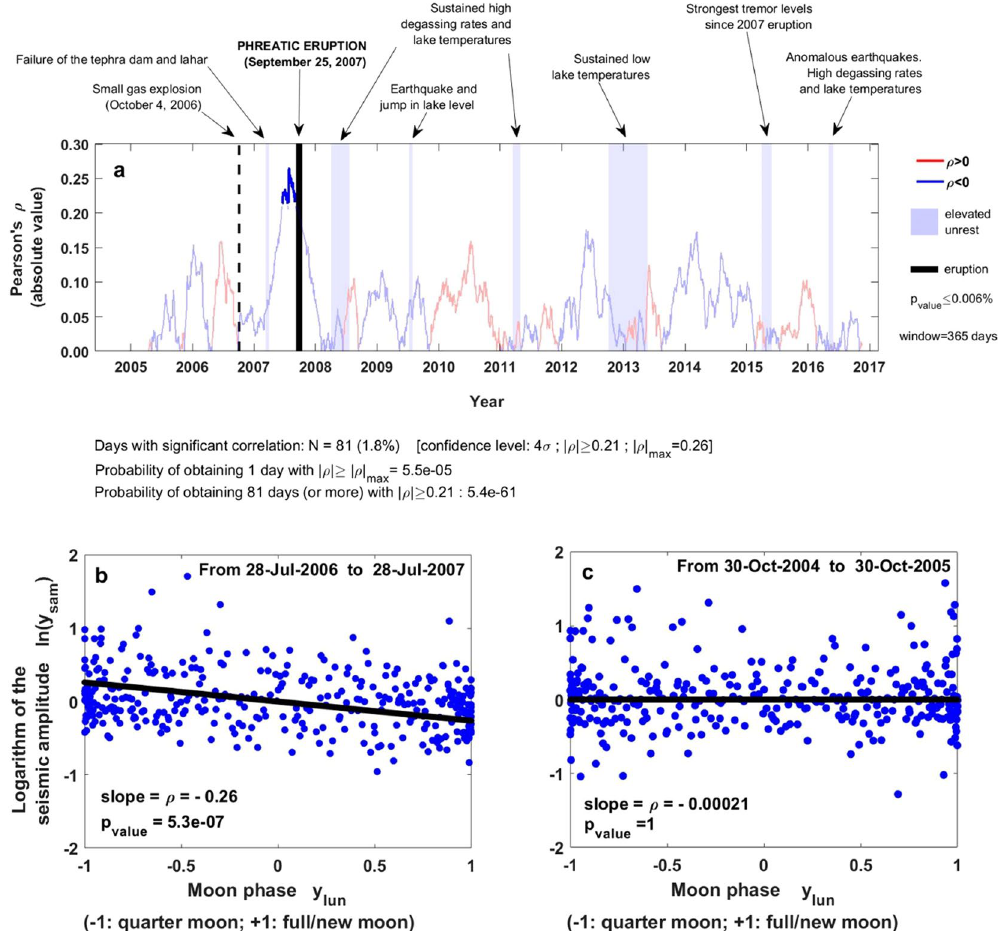
Figure 2. Luni-seismic correlation at Ruapehu. ( a ) Pearson coefficient ( ρ ) for 1-year backward windows. Positive and negative correlations are in red and blue, respectively, shaded regions represent unrest episodes 32 , and deep blue means p value < 0.006%. This plot depicts the case N = 81 days of significant correlation, but we find N = 59–86 days (after repeating the method 500 times) depending on the random values used to replace gaps and spikes (Methods, Section 1). The probability of obtaining by chance N days with significant correlation is therefore in the range ~10 − 36 –10 − 64 (Supplementary Fig. S5). ( b ) Logarithm of the daily median seismic amplitude ln ( y sam ) versus moon phase y lun ( t ) for the 365 days preceding July 28, 2007; this is the period with maximum correlation obtained. ( c ) ln ( y sam ) versus y lun ( t ) for the 365 days preceding October 30, 2005; no significant correlation exists in that